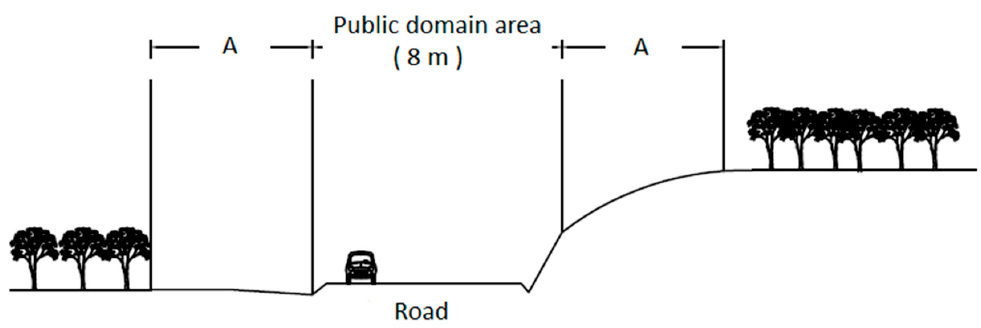
Figure 10. Scheme of distance between vegetation and roads. “A” distance ranges from 2 m to 10 m depending on the tree species.